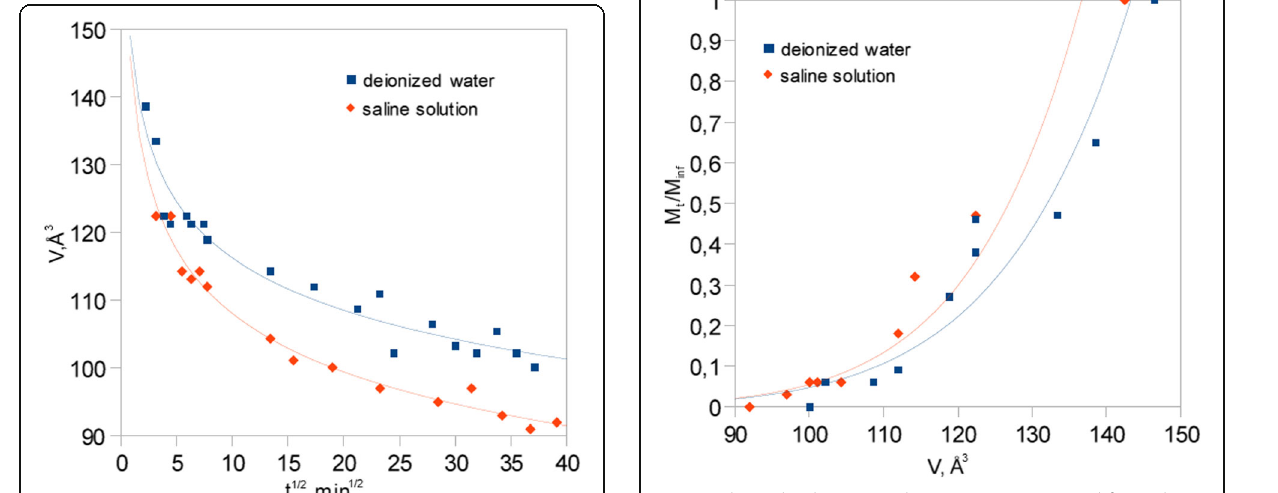
Fig. 8 Relationship between relative water content and free volume holes